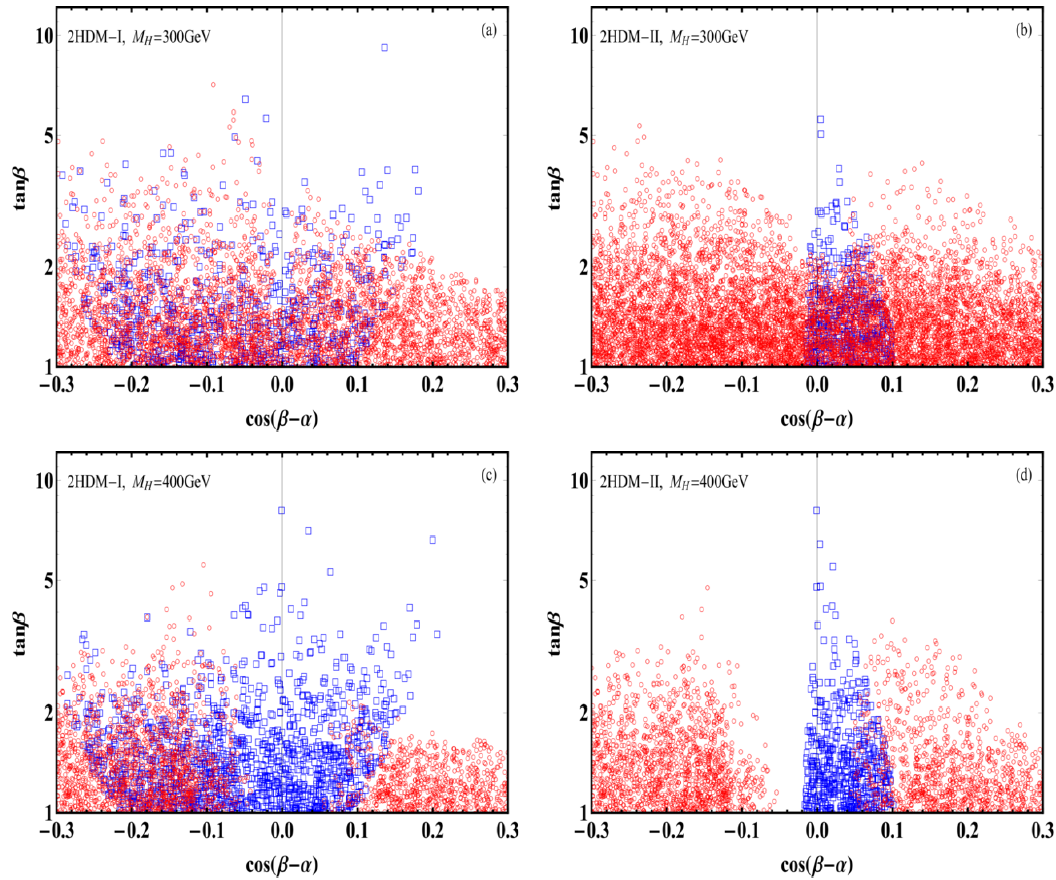
Figure 9 . Parameter space in cos( (cid:11) (cid:0) (cid:12) ) (cid:0) ln(tan (cid:12) ) plane for the sample inputs of heavier Higgs boson mass, M = 300 GeV [plots (a)-(b)] and M = 400 GeV [plots (c)-(d)], and for 2HDM-I [plots H H (a),(c)] and 2HDM-II [plots (b),(d)]. The blue dots (square shape) satisfy the theoretical